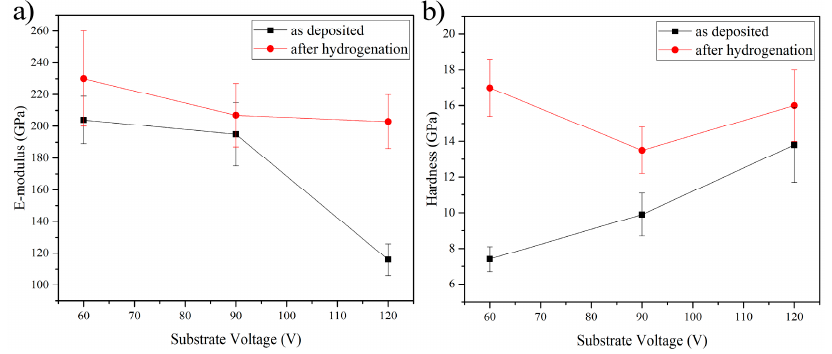
Figure 8. Mechanical properties ( a ) E -modulus and ( b ) hardness of CrN x coatings at various substrate voltages as-deposited and after hydrogen exposure. voltages as-deposited and after hydrogen